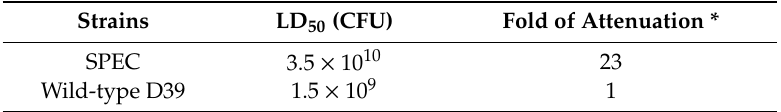
Table 1. Attenuated virulence of live SPEC strain in vivo.